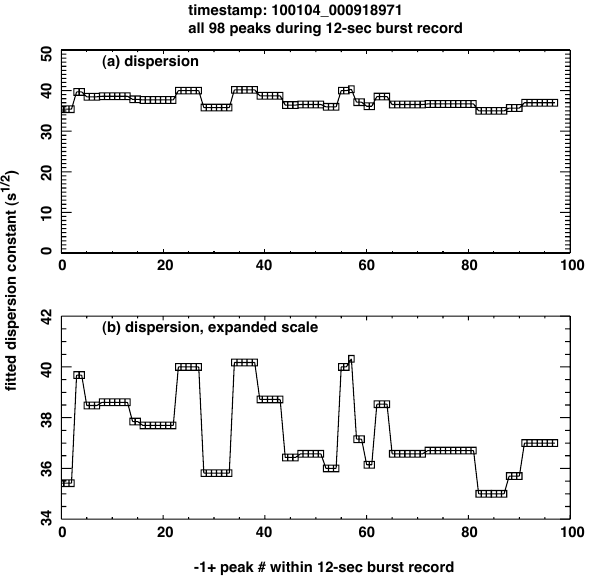
Fig. 6. Optimal dispersion constant for each of the 98 peaks se- lected within the burst recording of Fig. 1, vs. index of peak. Multi- ple peaks within the same analysis window forcedly have the same dispersion constant. (a) Dispersion constant, full scale on vertical. (b) Dispersion constant, zoomed to 34–42 (s 1 / 2 ) on vertical, show- ing variations during burst recording. Fig. 7. Effect of dechirp errors on the time-of-arrival of peak, us-